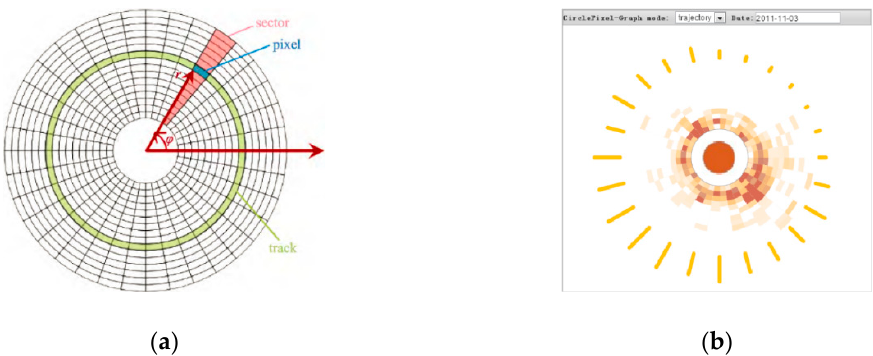
Figure 32. Circular pixmap design: ( a ) a prototype of circular pixmap; and ( b ) an example of circular pixmap [84].